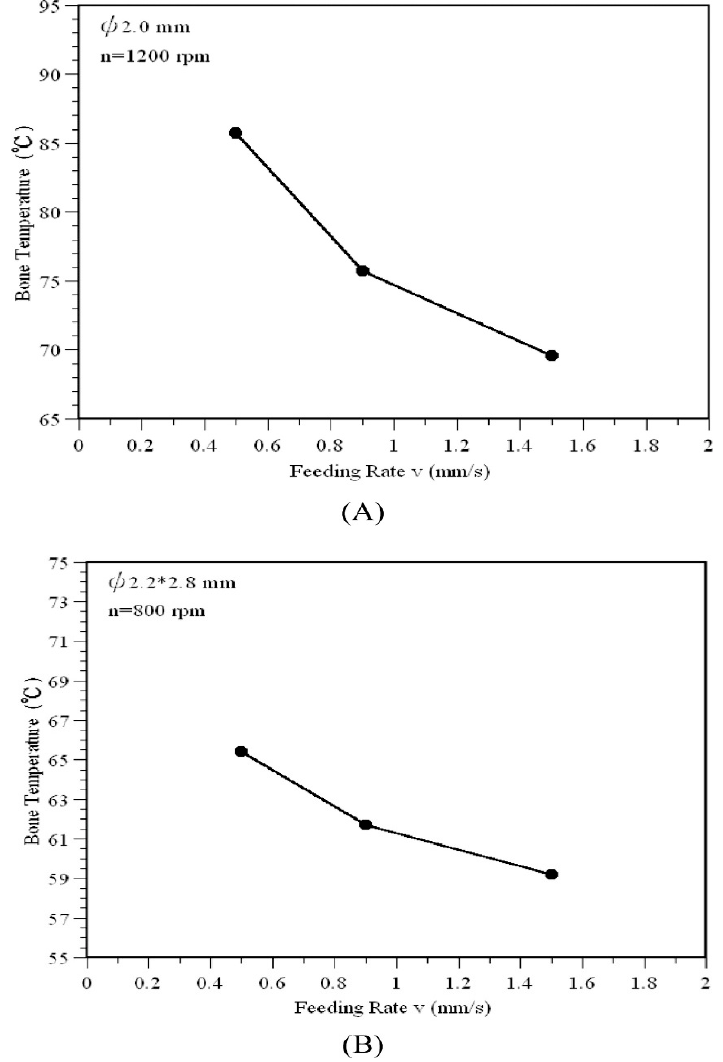
Figure 10. Maximum temperature decreases as the feed rate using two types of drills: ( A ) pilot drill, ( B ) twist drill [37].